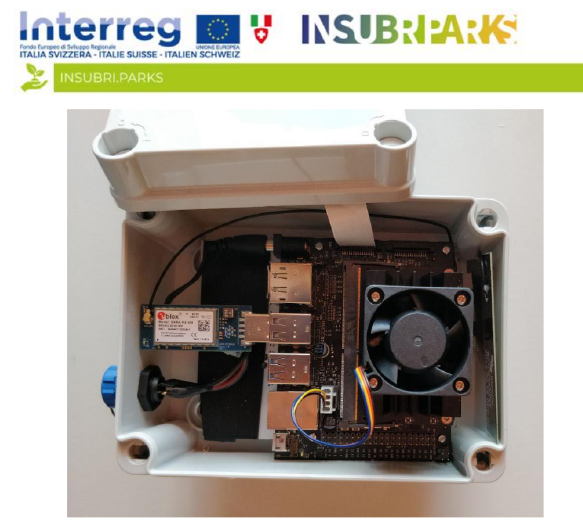
Figure 2. Prototype sensor to monitor touristic fluxes.